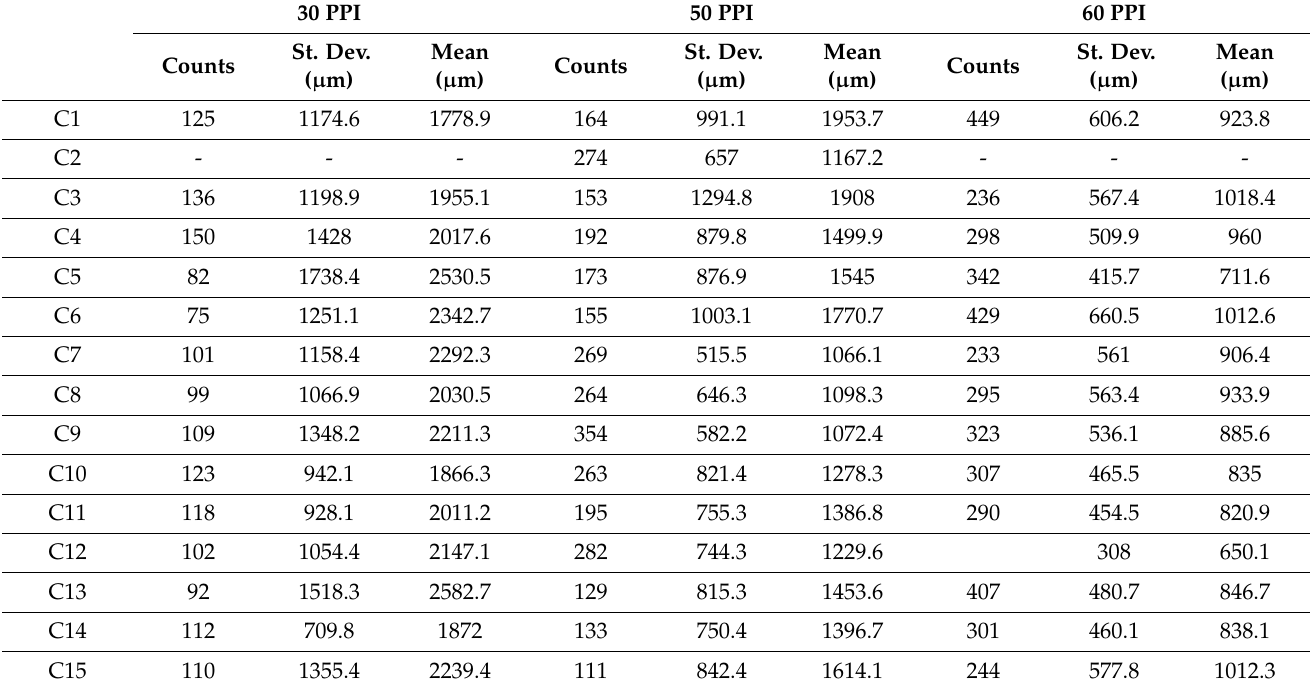
Table A12. Mean Cell’s Feret diameter ( d C ) of CFF samples of 30 PPI, 50 PPI and 60 PPI from supplier C.